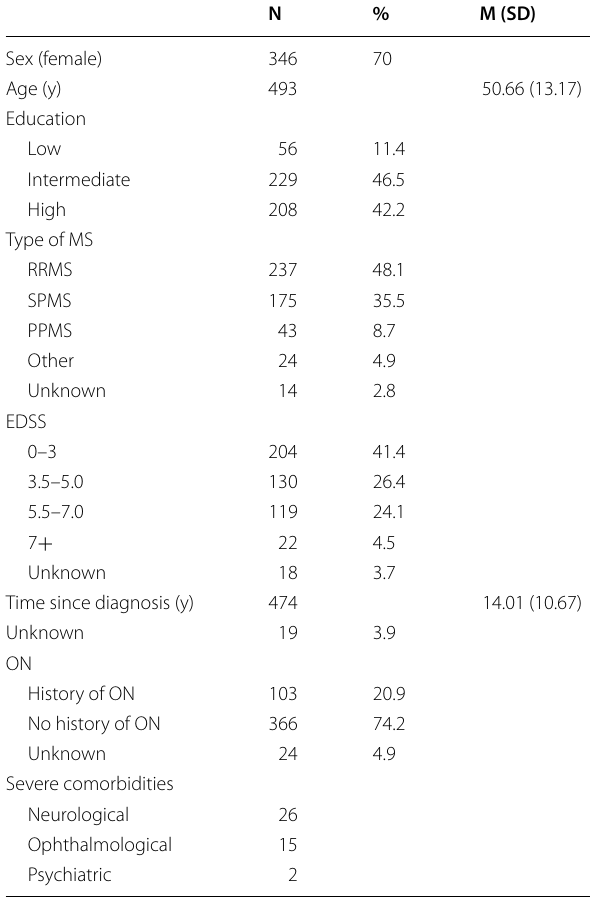
Table 1 Demographics and disease characteristics of the cohort of people with